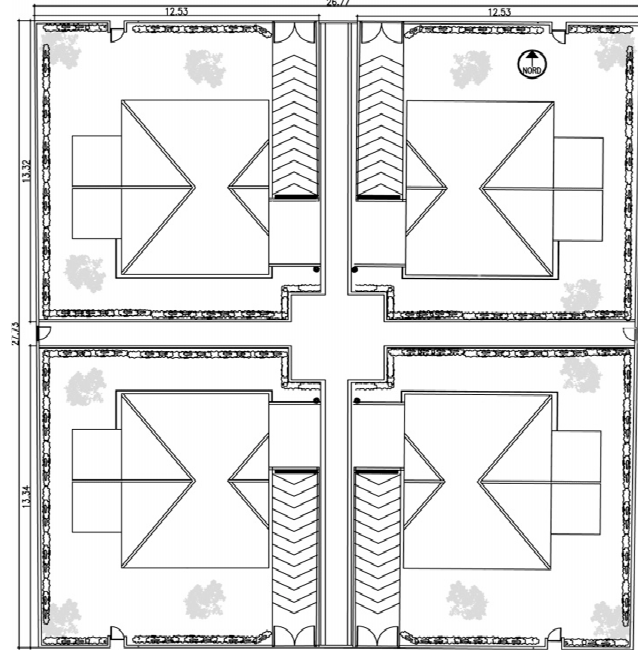
Figure 2. Plan of the examined four residential dwellings.